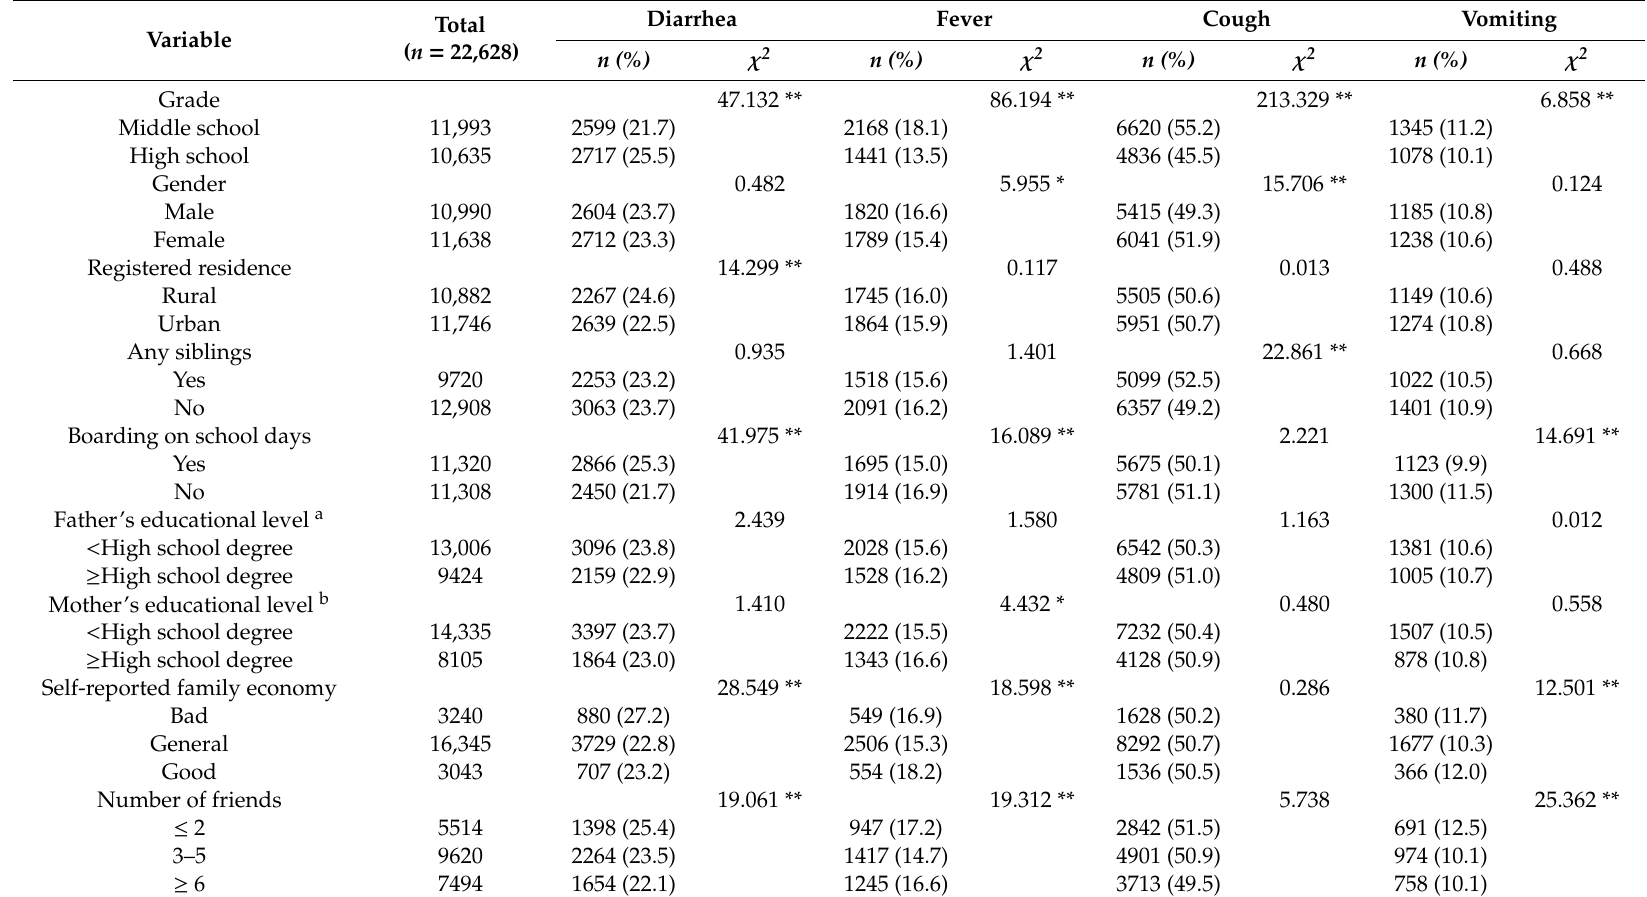
Table 1. Participant characteristics in the current